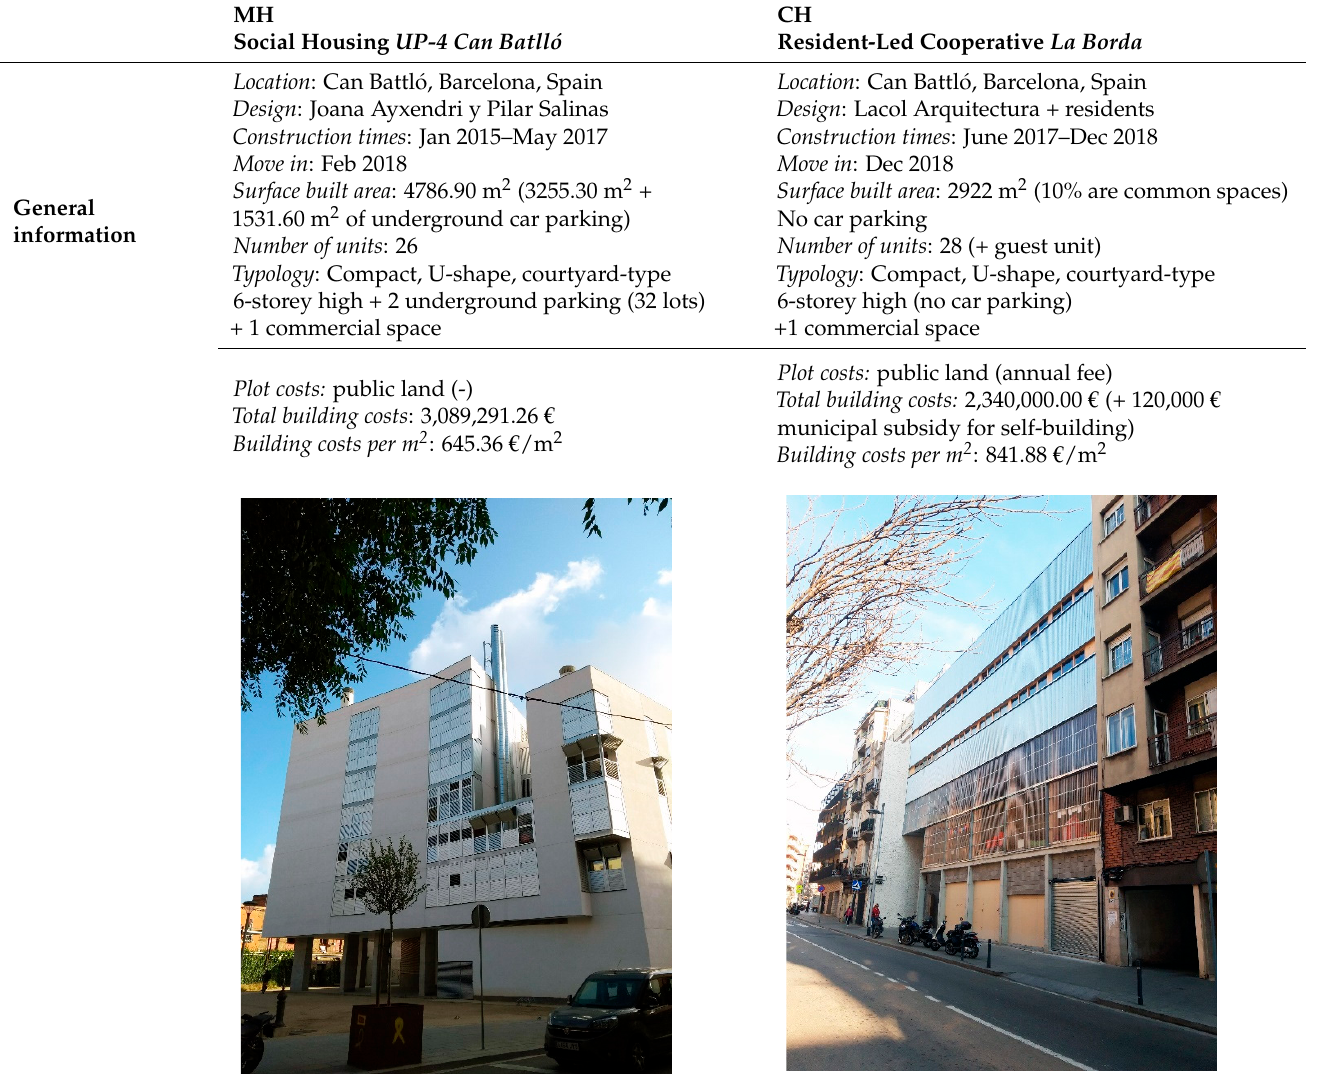
Table A1. General Information about the Design Features and Costs of UP-4 Can Batlló (MH) and La Borda (CH).